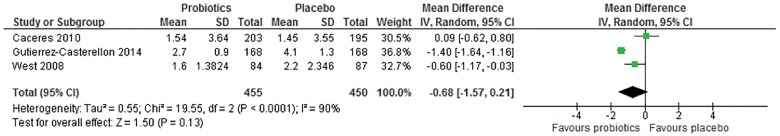
Mean number of days of antibiotic use